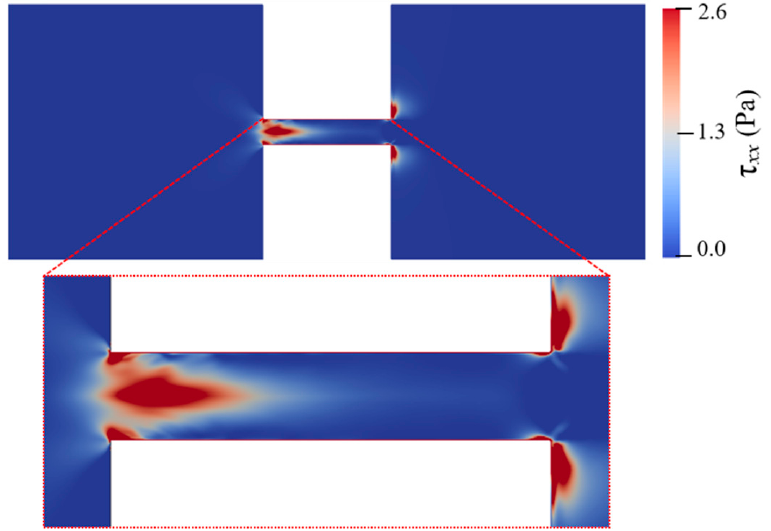
walls of the constriction microchannel is significantly higher than that at the centerline constriction microchannel. However, in the EOF of Newtonian fluid, as shown in Figure 10b, at both the entrance and exit of the constriction microchannel, the velocity magnitude is more evenly distributed in the cross section of the constriction microchannel. Figure 10c depicts the velocity magnitude profile at the entrance (2 x / H c = − 5) and exit (2 x / H c = 5) of the constriction microchannel. For Newtonian fluid, the velocity magnitude profile is identical at 2 x / H c = ± 5 and is symmetric about the x -axis. The ratio of the maximum velocity magnitude near the channel walls to that at the centerline is 1.6. However, for PAA solution, due to the elastic instability, the velocity magnitude profile is asymmetric about the x -axis at 2 x / H c = ± 5. In addition, the ratios of the maximum velocity magnitude near the channel walls to that at the centerline are 9.7 and 4 at 2 x / H c = − 5 and 2 x / H c = 5, respectively, which are much higher than that of the Newtonian fluid. For Newtonian fluid, the velocity profile is symmetric about the centerline of the microchannel (i.e., y = 0). However, Figure 10c shows that the local maximum velocity near the top channel wall differs from that near the bottom channel wall, and the velocity profile is asymmetric about y = 0.